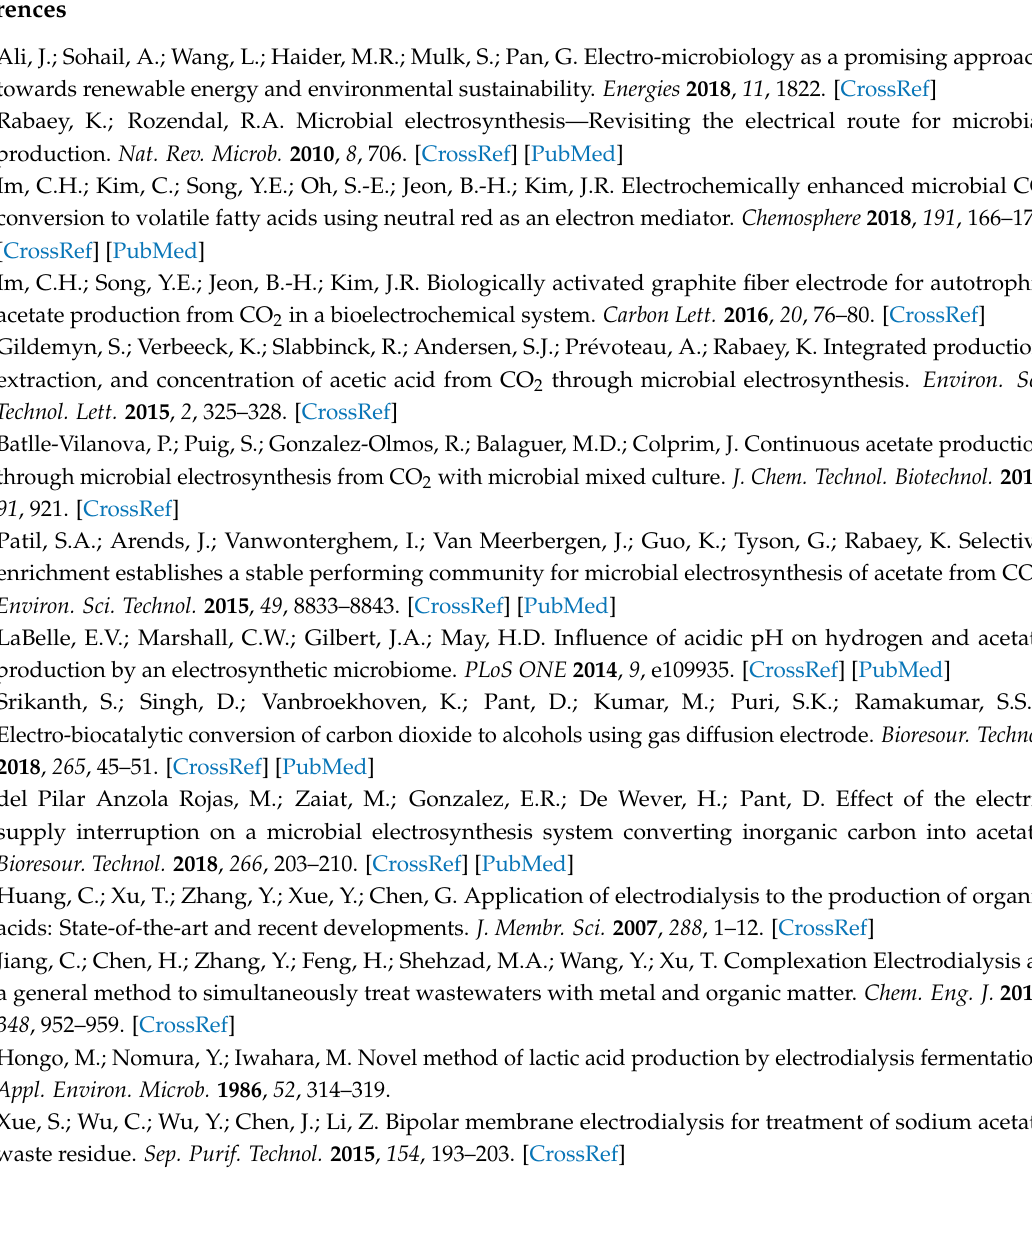
Figure S1. Schematic diagram of the electrodialysis reactor used in this study and a photograph. Figure S2. Comparison of propionate transfer through an anion exchange membrane. (A) Amount of propionate transferred to the anodic chamber, (B) applied current in the reactor for 16 h, (C) GC analysis results of the fermentation broth, (D) GC analysis results of the synthetic medium. Figure S3. Membrane and cathodic electrode surface after the completion of electrodialysis for acetate separation. membrane (A) and cathodic electrode (D) from the cell using synthetic broth meida, respectively. (B,E) from centrifuged fermentation broth, (C,F) from non-centrifuged fermentation broth. Figure S4. Estimated current efficiency on different parameters tested. (A) Current efficiency of different currents from − 5 mA to − 20 mA, (B) Effects of the initial acetate concentration, (C) Effects of different initial anodic pH, (D) Effects of different catholytes with synthetic media (a), centrifuged fermentation broth (b) and non-centrifuged fermentation broth